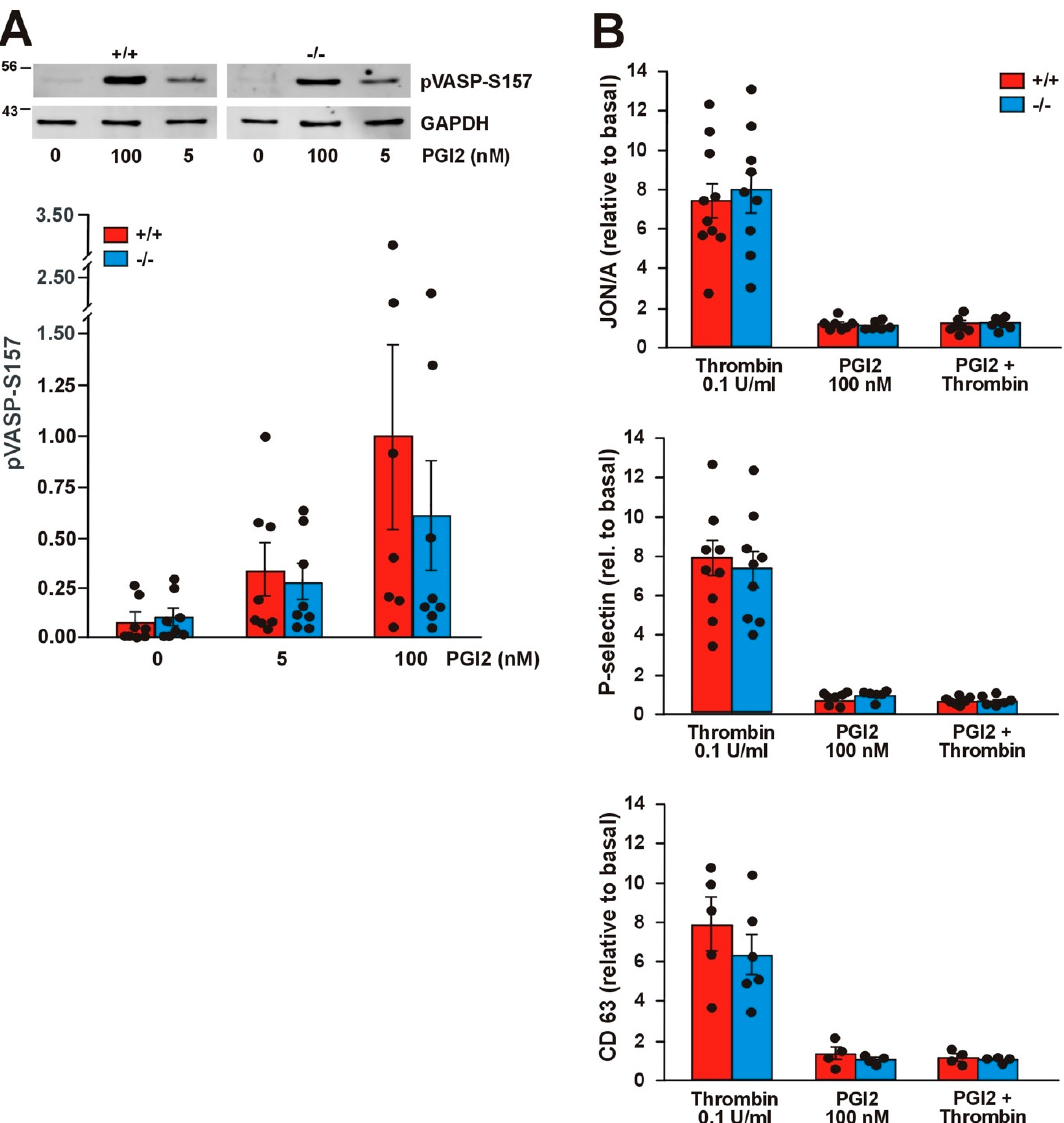
Figure 7. The cAMP pathway is not affected in Coro1a deficient platelets. ( A ) Phosphorylation of vasodilator-stimulated phosphoprotein (VASP) upon prostacyclin (PGI2) stimulation for 5 min at the indicated doses. Platelet lysates were resolved by SDS-PAGE, blotted, and probed with specific antibodies for pVASP-Ser157. GAPDH was used for normalization. Representative blots and bar diagrams showing mean ± SEM of 7 independent experiments. Full blots are shown in Supplemental Figure 2; ( B ) Integrin activation, P-selectin exposure, and CD63 exposure upon stimulation with thrombin prior to PGI2. Platelets in PRP were treated with 100 nM PGI2 for 5 min prior to stimulation with 0.1 U/mL thrombin and subsequently analyzed by flow cytometry. This set of experiments was carried out simultaneously with the ones presented in Figure 3. The data (median fluorescence intensity) are expressed relative to basal (unstimulated) platelets. The data represent the mean ± SEM of 4–9 independent experiments. No significant differences were found between WT and KO in any of the assays (Student’s t -test or Mann–Whitney